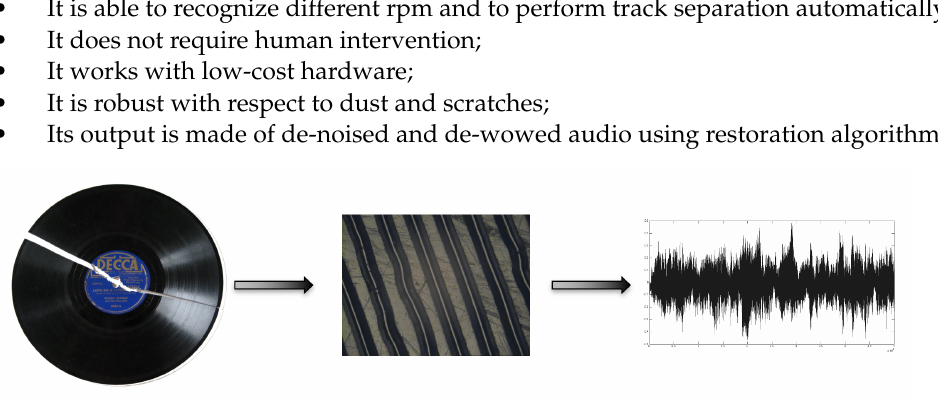
Figure 12. Photos of the GHOSTS system for reconstructing the audio signal from a still image of the surface of shellac